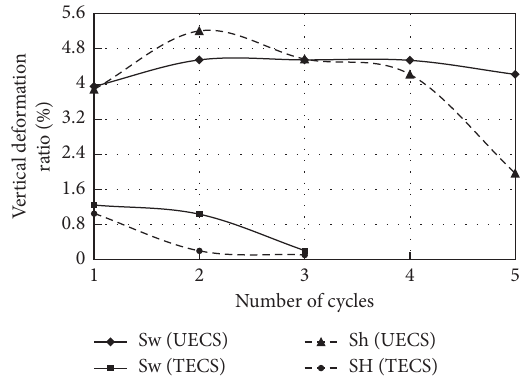
Figure 14: Swelling/Shrinkage potential versus the number of cycles for UECS and TECS.